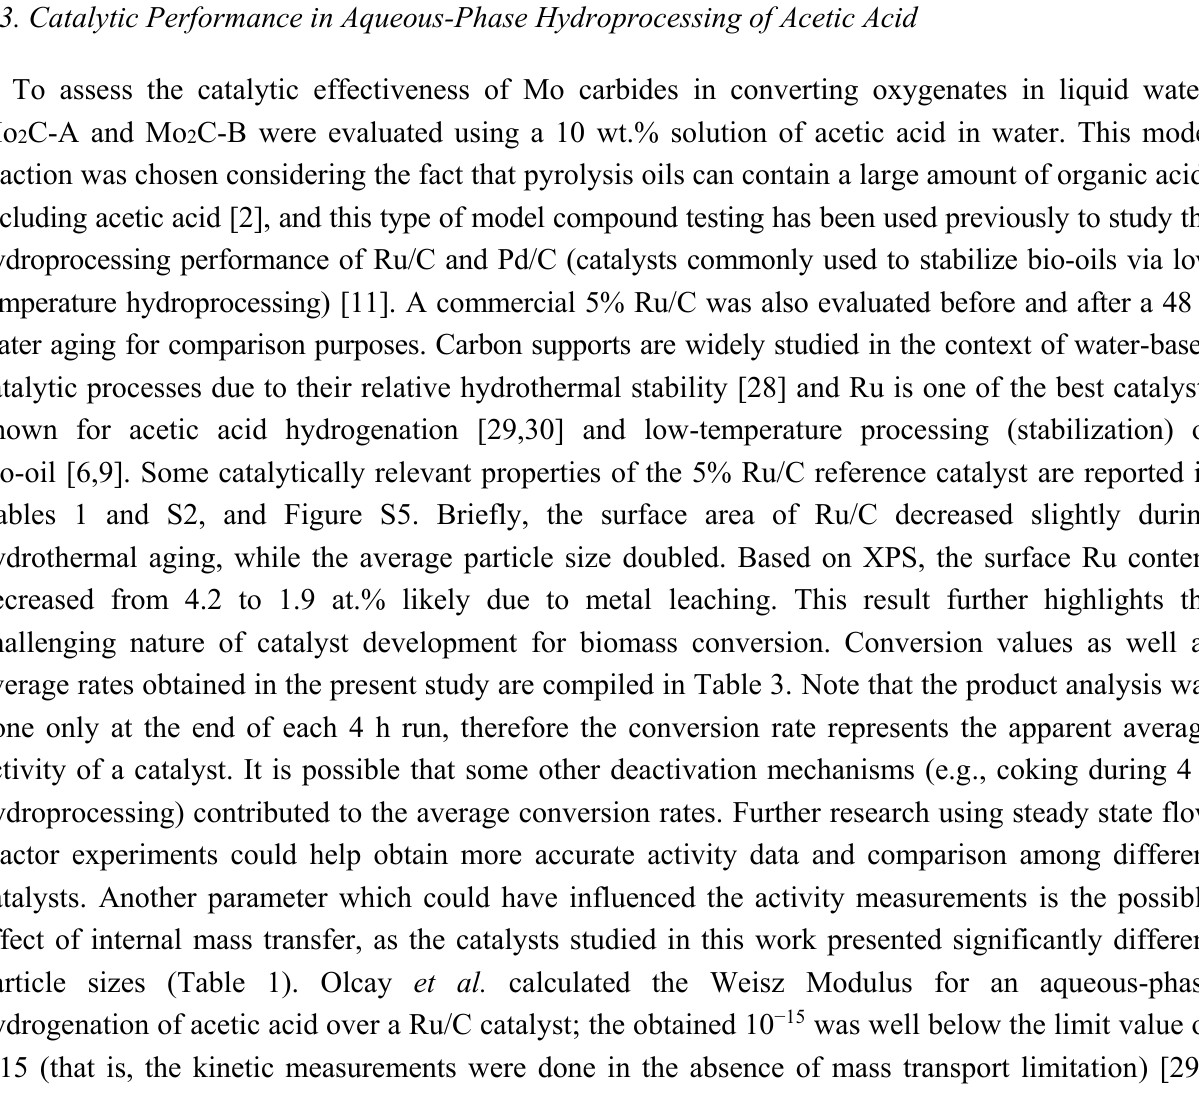
Figure 6. TGA profiles of two Mo 2 C samples in the fresh state and after 48 h aging at 250 °C in liquid water. Temperature increased from room temperature to 800 °C at 10 °C/min in air (25 mL/min). The solid and dashed lines correspond to the relative weight change of Mo 2 C-A and Mo 2 C-B samples,